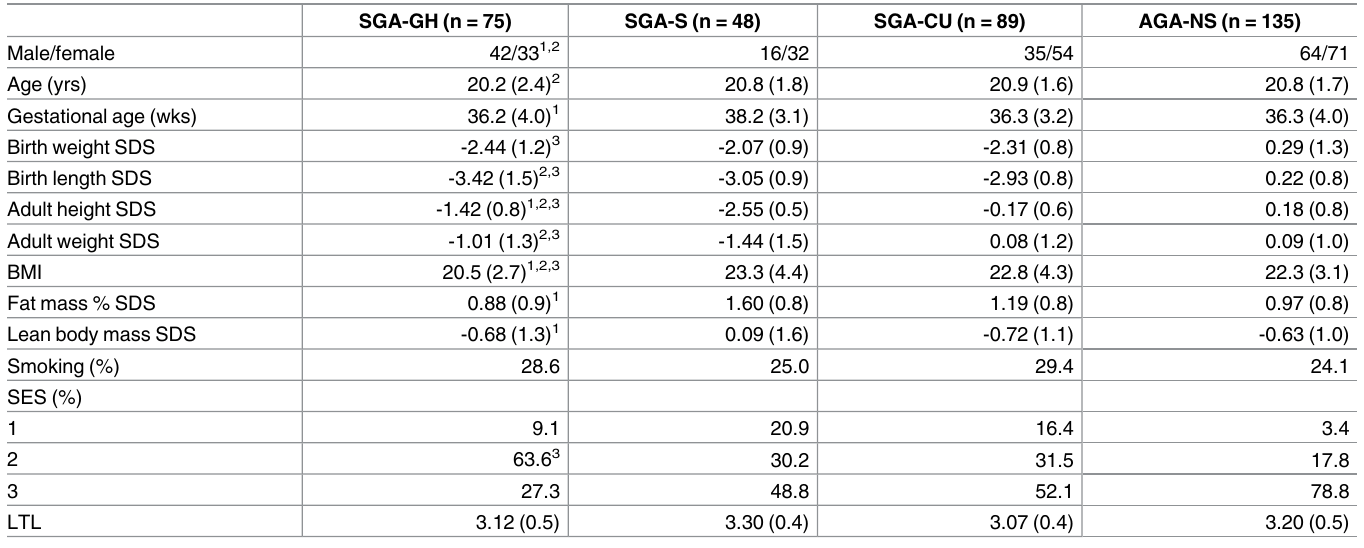
Table 4. Clinical characteristics of the subgroups.